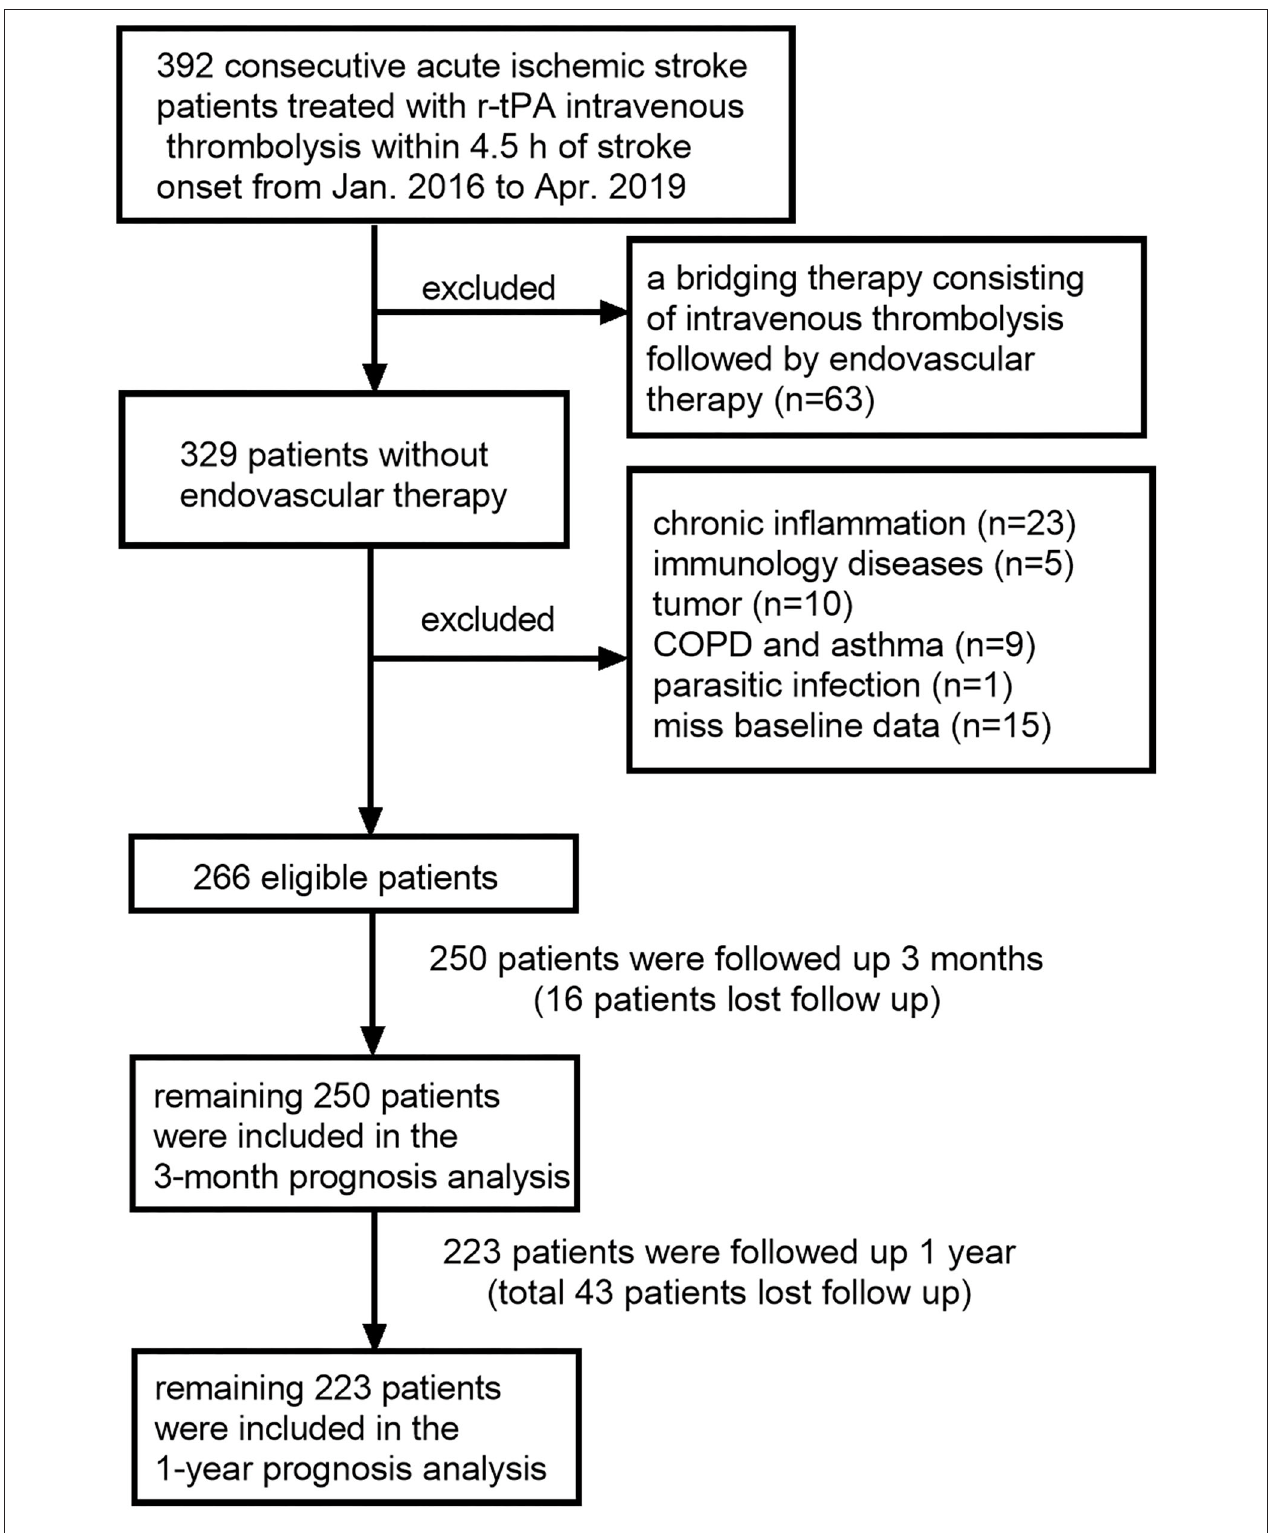
FIGURE 1 | Flowchart for patient